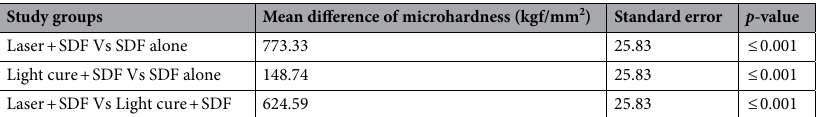
Table 1. Post hoc test for microhardness mean difference of the three study groups.